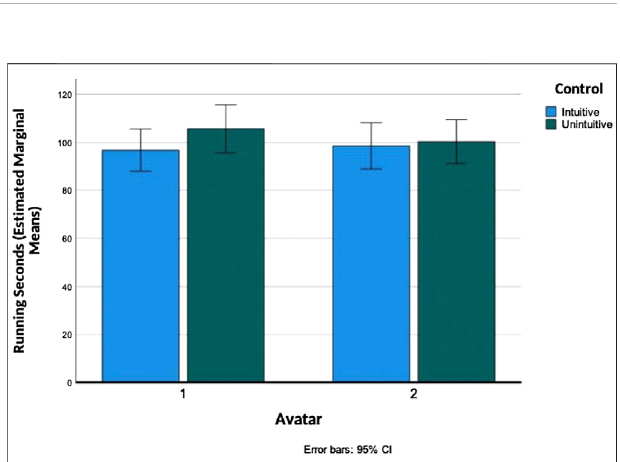
FIGURE 4 | Estimated marginal means of run time in